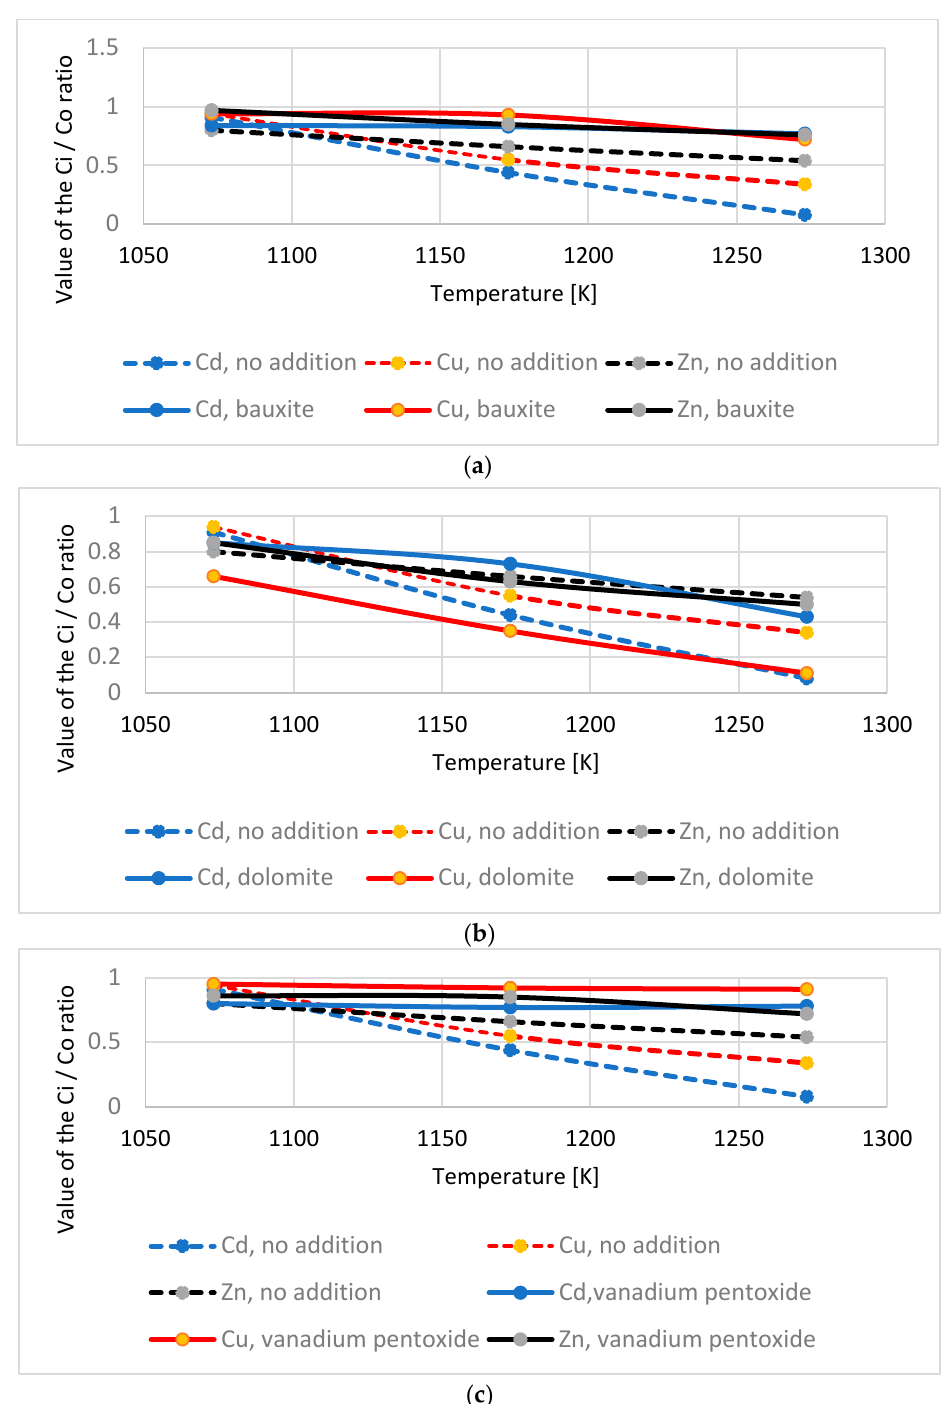
Figure 2. Dependence of the Ci/Co value on the roasting temperature in the samples of nitrates (V); ( a ) with the addition of bauxite, ( b ) with the addition of dolomite, ( c ) with the addition of V 2 0 5.